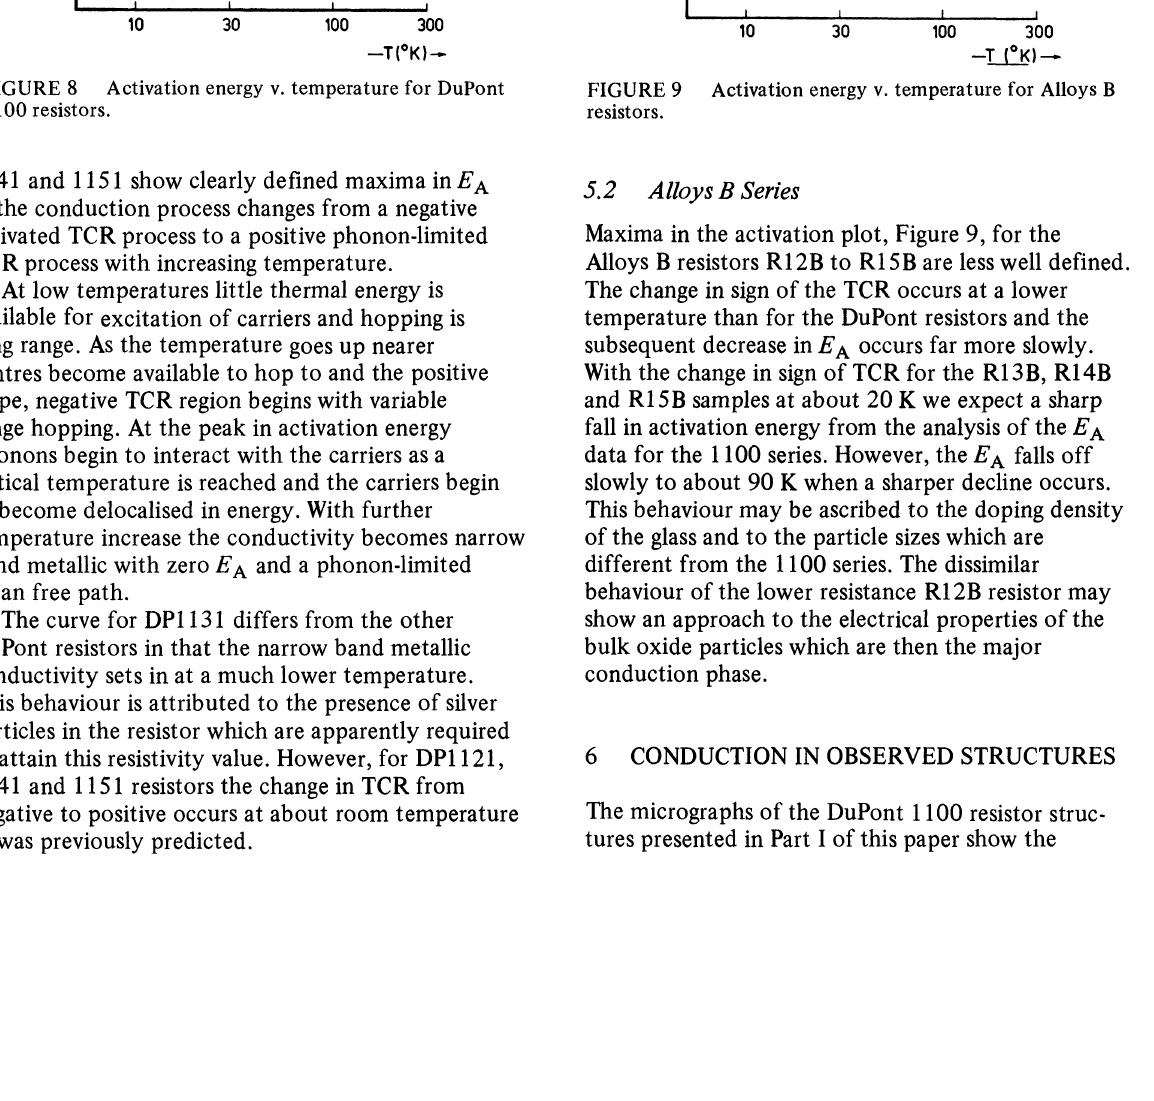
Activation energy v. temperature for DuPont 1100